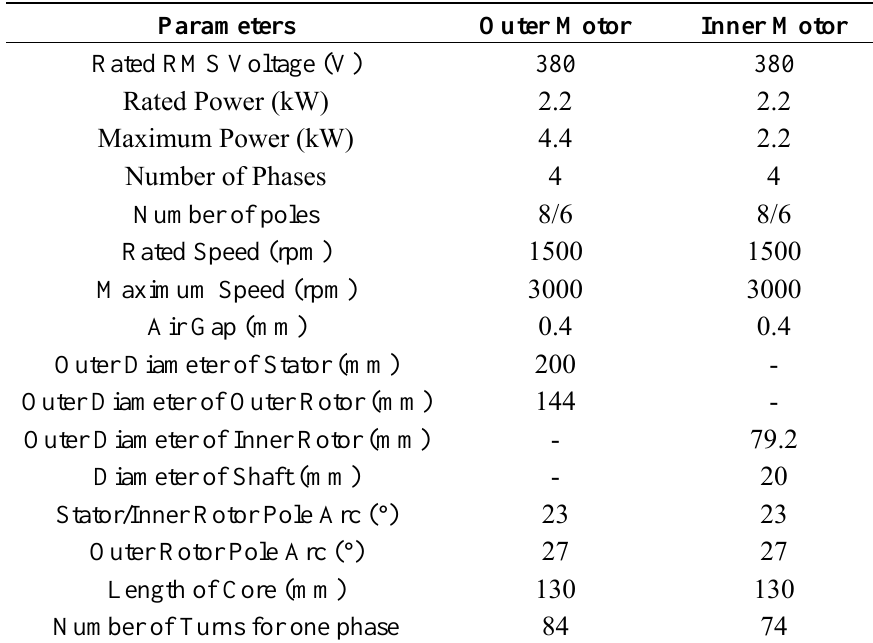
Table 1. Main parameters of the SRDRM.